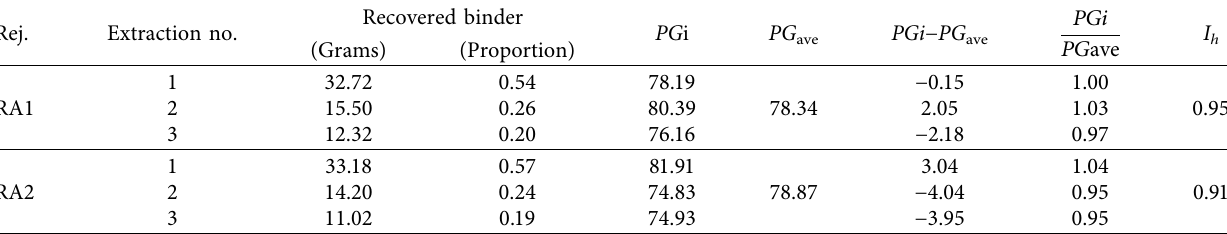
Table 2: Stage extractions for rejuvenator selection process.